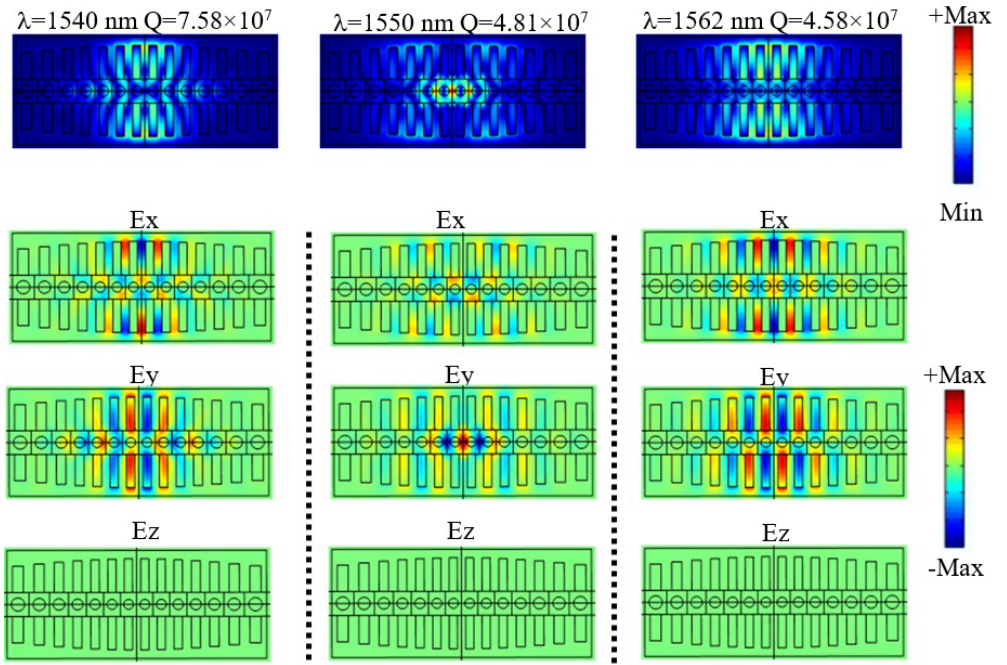
Figure 6. Maps of the optical cavity modes for the tapered OM cavity. Top pictures: E field magnitude, bottom pictures: real part of the E field components. Their imaginary parts are very small and not